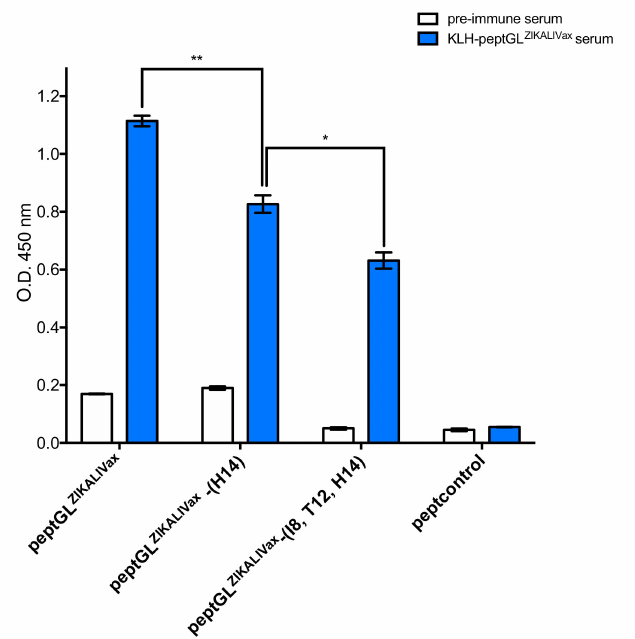
Figure 5. KLH-peptGL ZIKALIVax immune serum reacts with peptGL ZIKALIVax . The O.D. 450 or